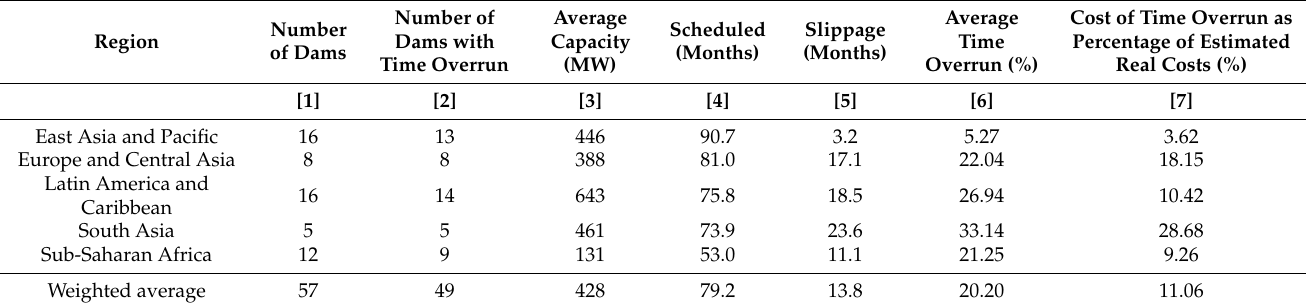
Table 8. Incidence and cost of time overruns across various